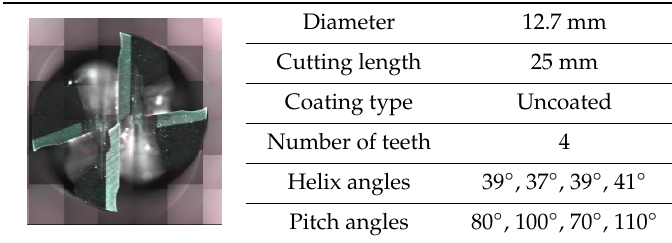
Table 2. Main geometric parameters of multivariable tool.